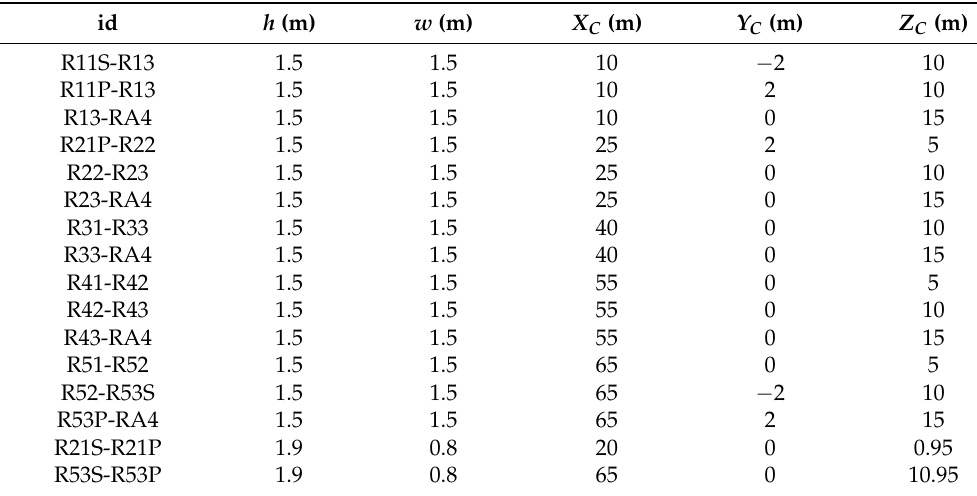
Table 2. Main characteristics of the test case openings. C = ( X C , Y C , Z C ) is the centre of the opening in ship-fixed reference